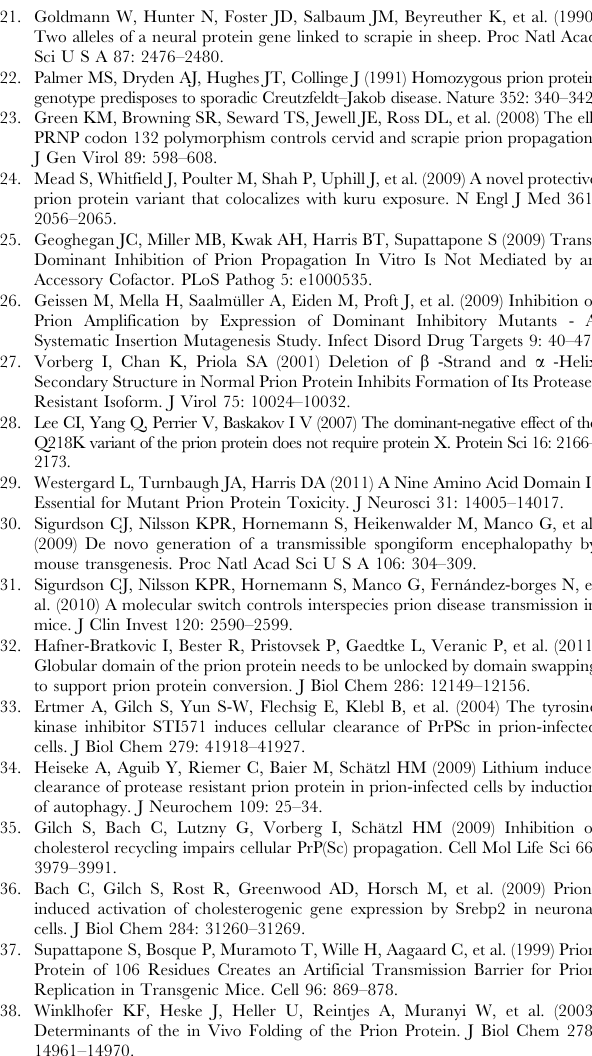
Table S1 Primers used for creating D PrPs. The term ‘‘Rev’’ in primer names indicates anti-sense primers. Antisense primer ‘‘Common Rev. D 159-X’’ was combined with sense primers whose names start with ‘‘ D 159-’’ to create the internal deletions as indicated by the name of the sense primers by site- directed mutagenesis. Likewise, primer ‘‘Common D X-175’’ was combined with antisense primers whose names end with ‘‘-175’’